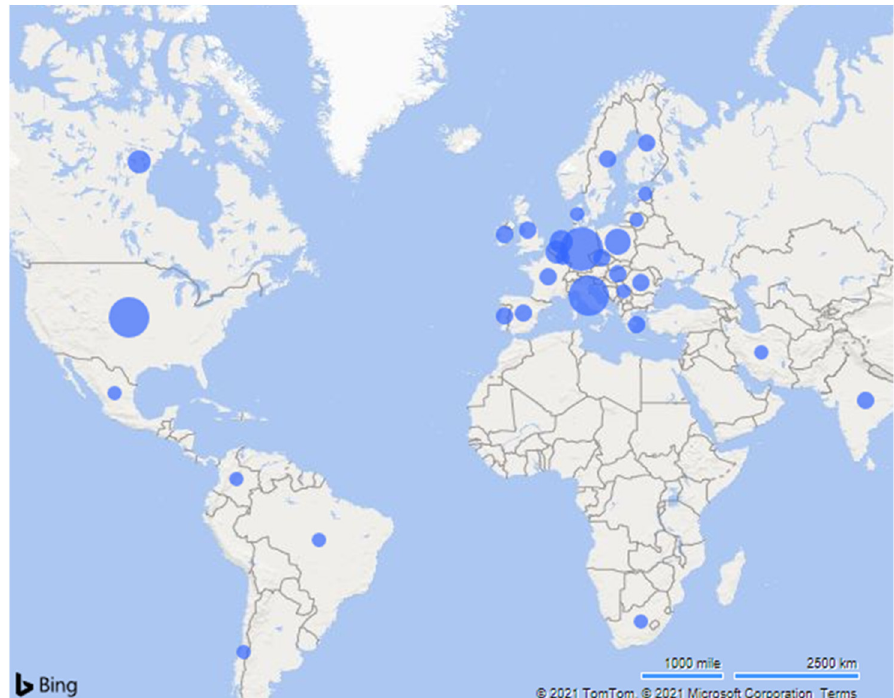
Figure 2. Map of papers’ authors by country of origin with regard to papers concerned with economic analysis of perennial crops for energy.